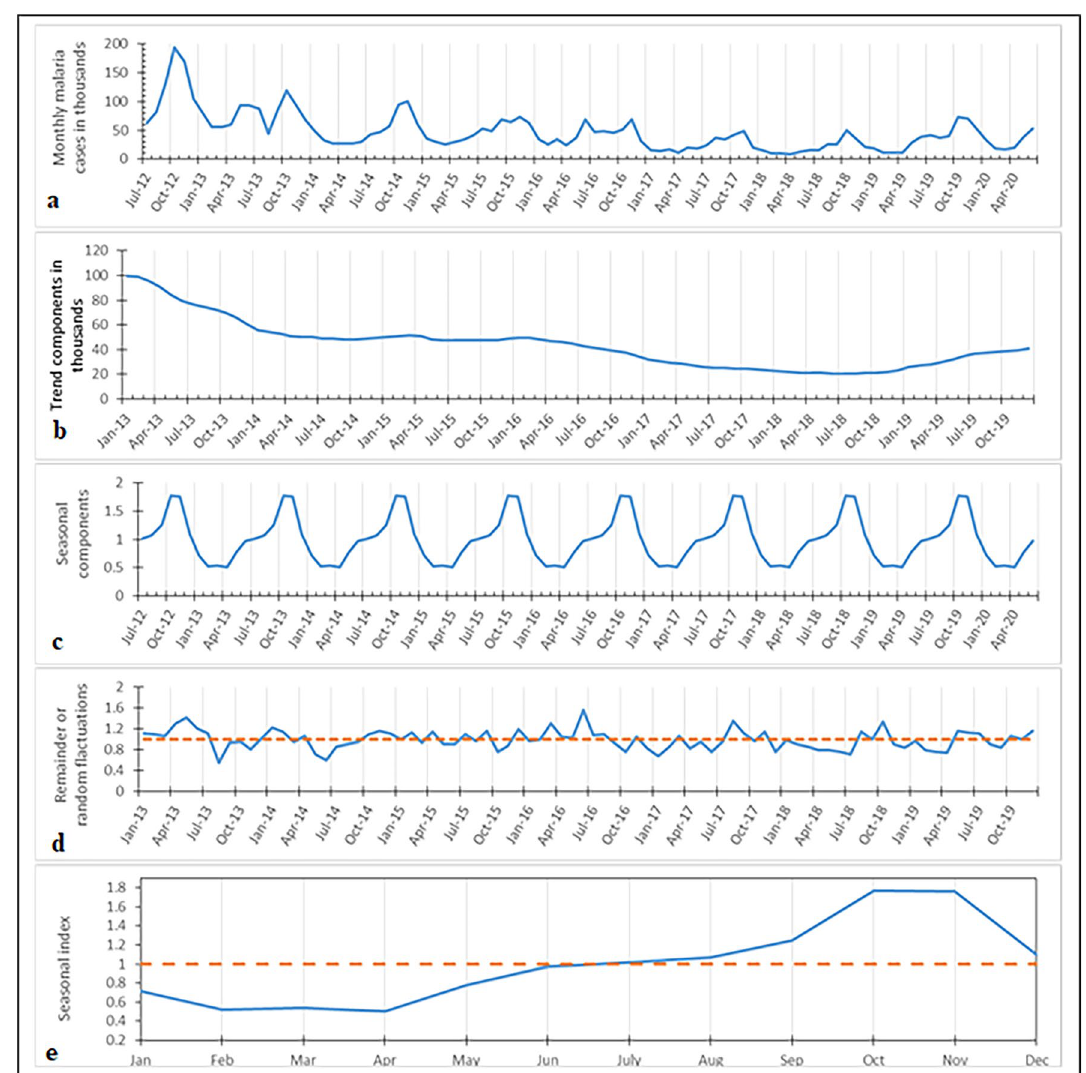
Figure 2. Seasonal distribution of monthly malaria cases between 2012 and 2020, in northwest Ethiopia; ( a ) time series of monthly malaria cases of the region; ( b ) is a long term trend; ( c ) is a seasonal trend decomposed from the time series of malaria cases; ( d ) the residual data after excluding seasonality and long term trend; and ( e ) estimated seasonal index of 12